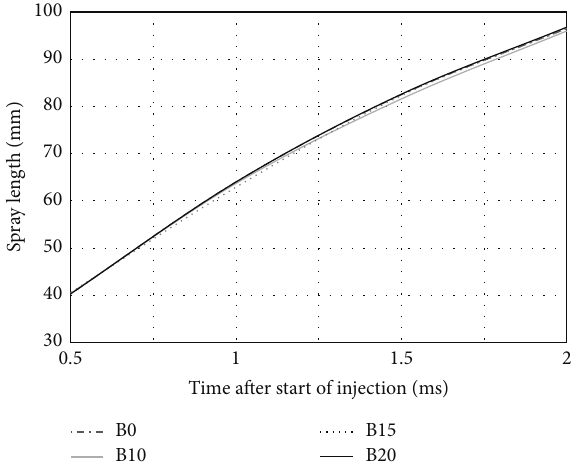
Figure 14: Liquid phase spray length of different HFO/n-butanol blends at injection pressure of 1000bar.